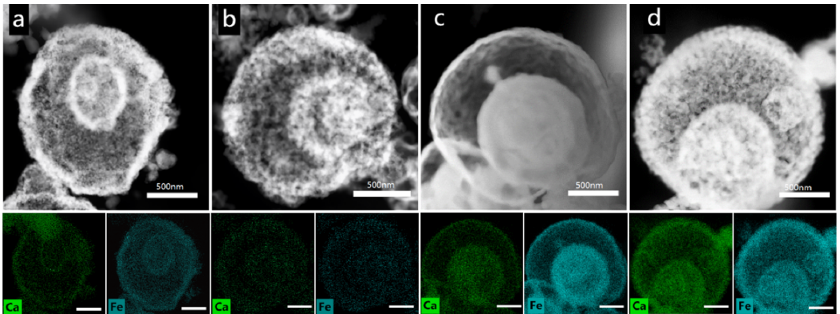
Figure 3. HAADF-STEM images of ( a ) Ca90Fe10, ( b ) Ca85Fe15, ( c ) Ca80Fe20 and ( d ) Ca75Fe25 along with EDS elemental mapping.